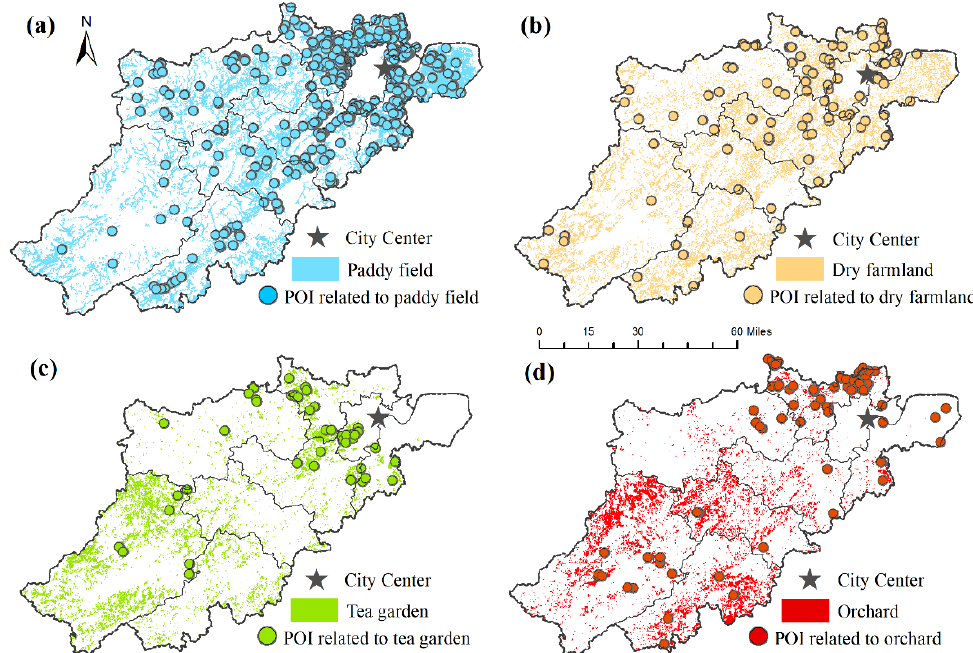
Figure 6. Distribution of different agricultural land types and the location of POIs related to each of them: ( a ) paddy field, ( b ) dry farmland, ( c ) tea garden, and ( d ) orchard.